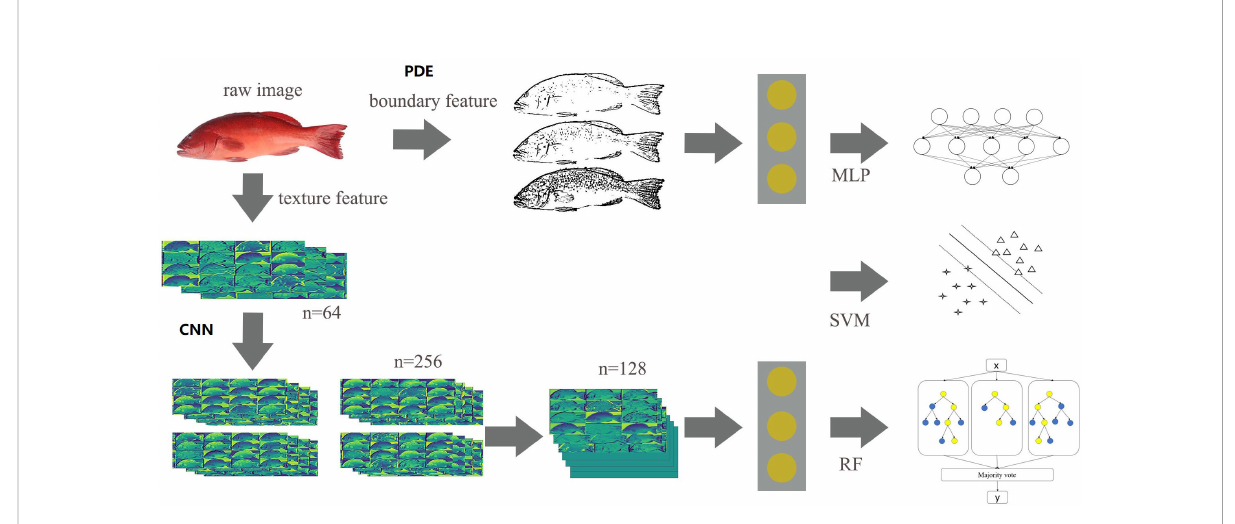
FIGURE 1 The essential architecture of our method for fully automated segmentation and identi fi cation of P. leopardus